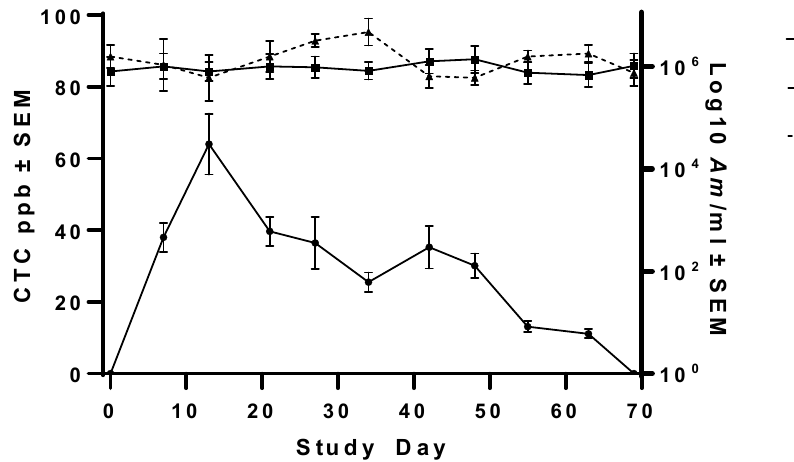
Figure 1. Changes in Am bacteremia in steers treated with chlortetracycline (CTC) for 60 days. CTC concentration, in parts per billion (ppb) ± standard error of mean (SEM), is plotted over time with bacteremia ( Am /mL blood) ± SEM for animals treated daily with 1.1 mg/kg bodyweight CTC for 60 days. Untreated control steer mean Am bacteremia is included for comparison. CTC treatment was not found to have a significant ( p > 0.05) effect on reducing Am bacteremia.